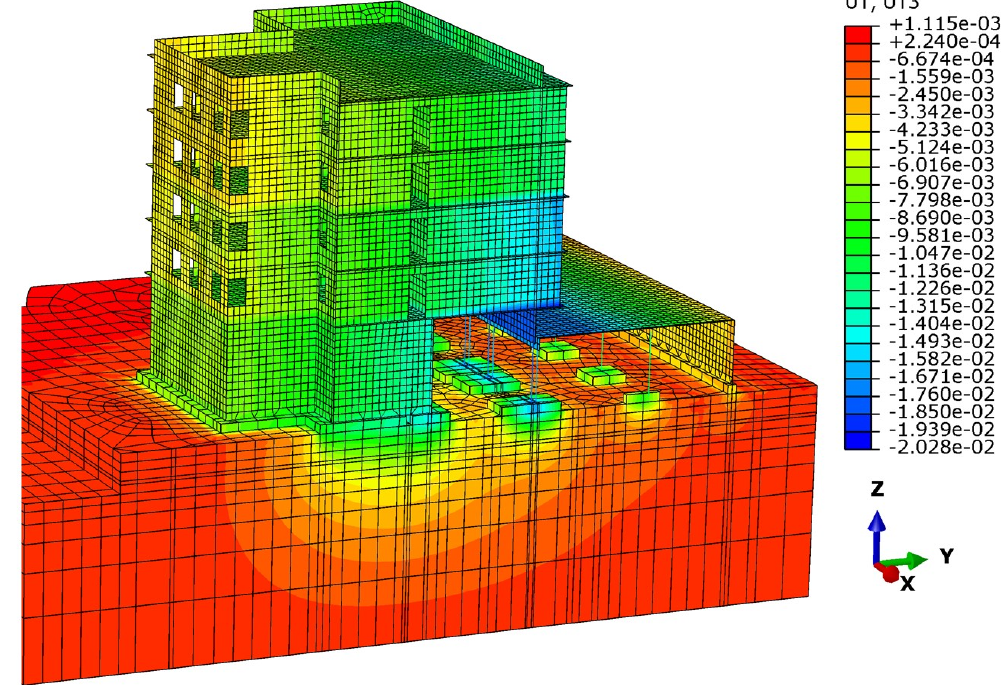
Figure 17. A map of vertical displacements [m] in a cross-section of the building in the AREA variant.